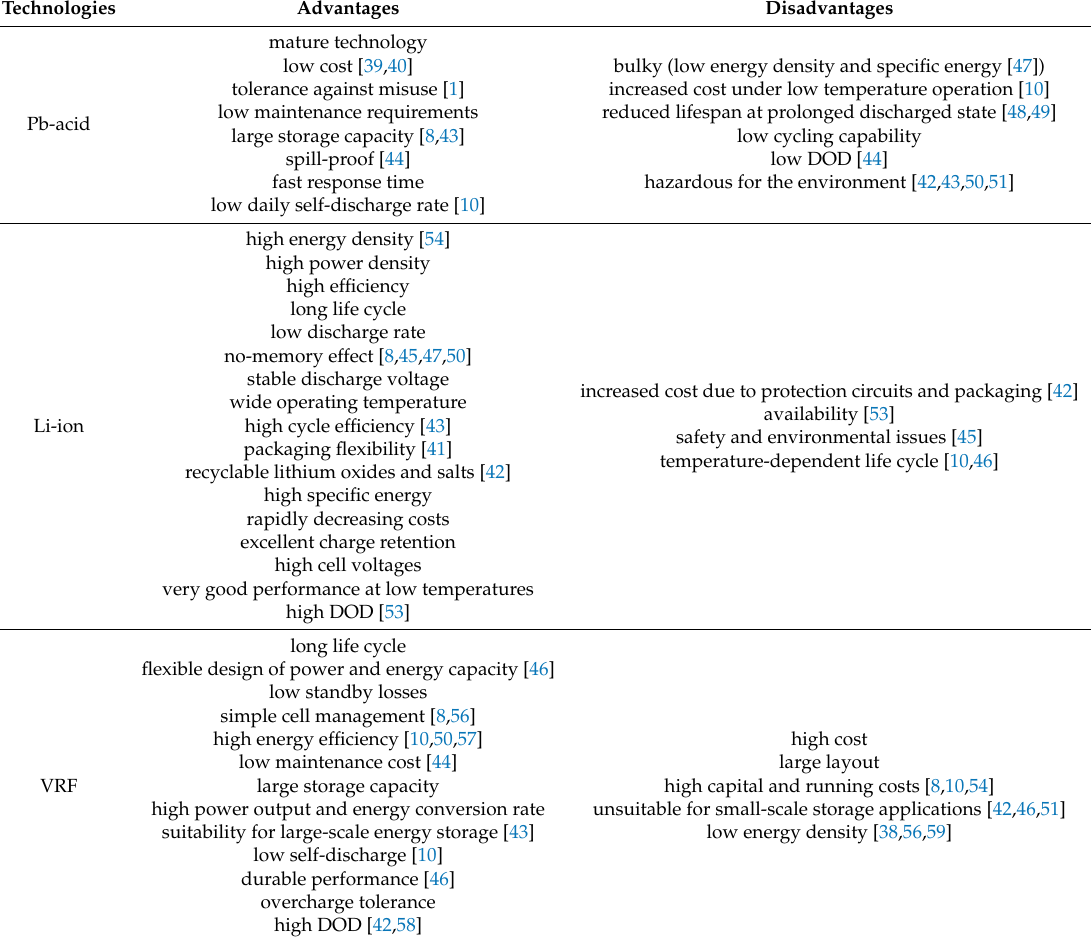
Table 3. Main advantages and disadvantages of the BESS technologies described in Section 3.